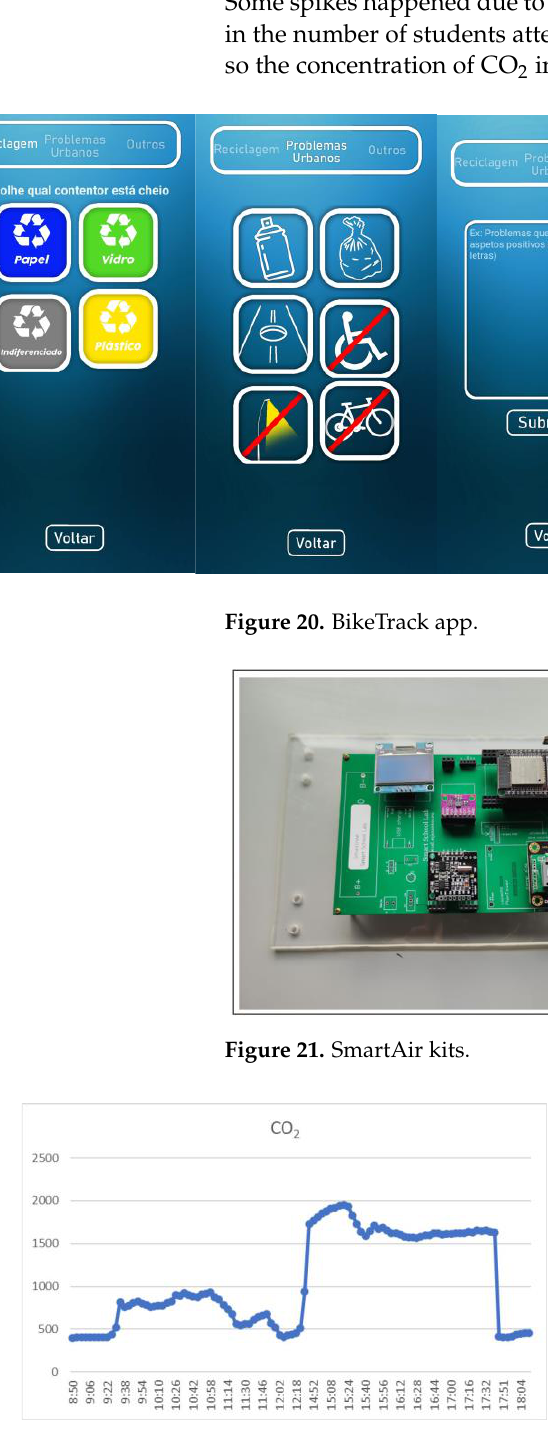
Figure 22. One day CO 2 level inside a classroom and PM outside the school.